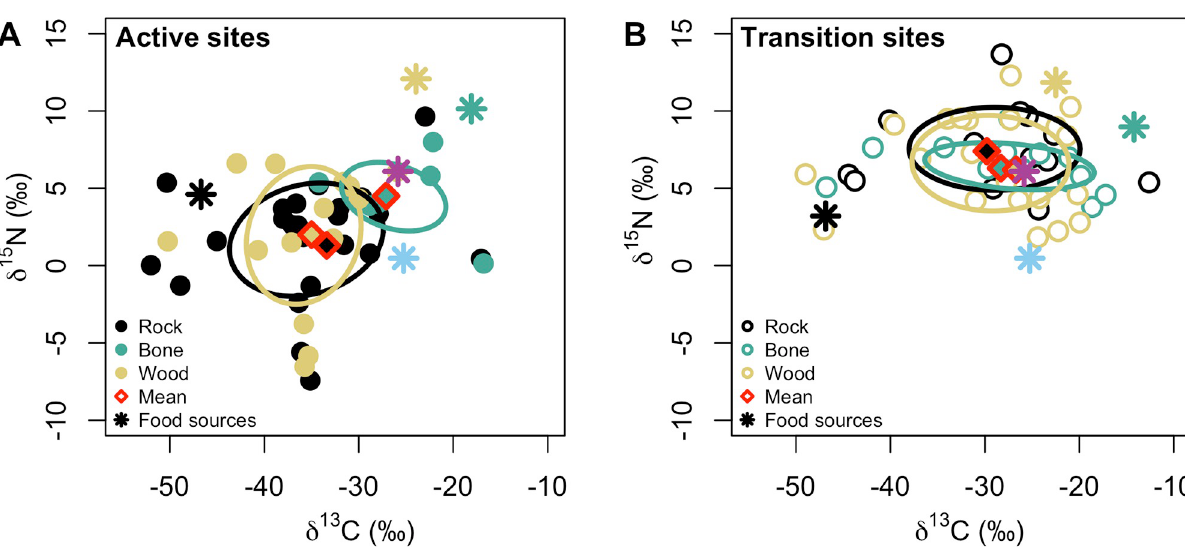
Fig 8. Trophic niche diversity of macrofaunal colonizers on the experimental substrates. Dual isotope plots reflecting macrofaunal invertebrate community trophic niche diversity based on corrected standard ellipse area on in situ carbonate rocks (black) and bone (green) and wood (yellow) deployed for 7.4 years (2010–2017) at Mound 12 at (A) active and (B) transition sites. Each point represents the average for one species. Diamonds represent the mean isotopic values for the macrofaunal invertebrate community on each substrate. Stars represent the mean isotopic values for food sources: rock (black), bone (green), wood (yellow), bacteria (blue), and POC (pink). Error bars were omitted for simplicity. Data are available in S1 File.